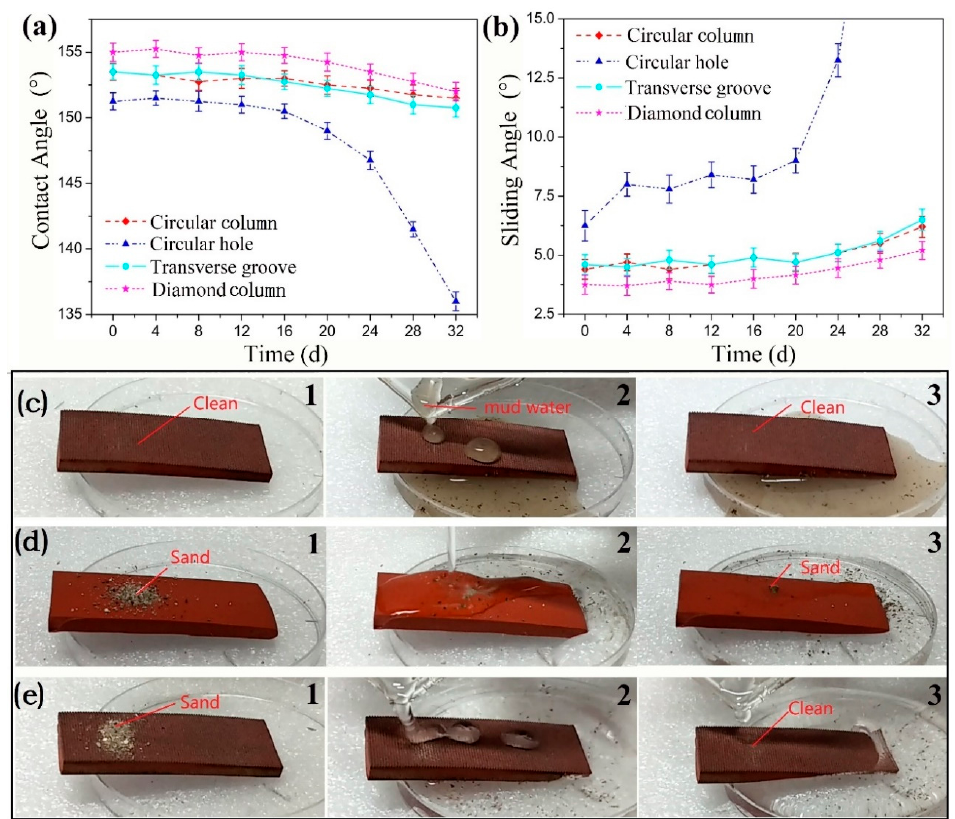
Figure 7. The curves of ( a ) the CAs and ( b ) the SAs of the droplet on different texture surfaces with the time, ( c ) the anti-fouling test of the textured surface with transverse grooves and the self-cleaning test of ( d ) the original sample surface and ( e ) the textured surface with transverse